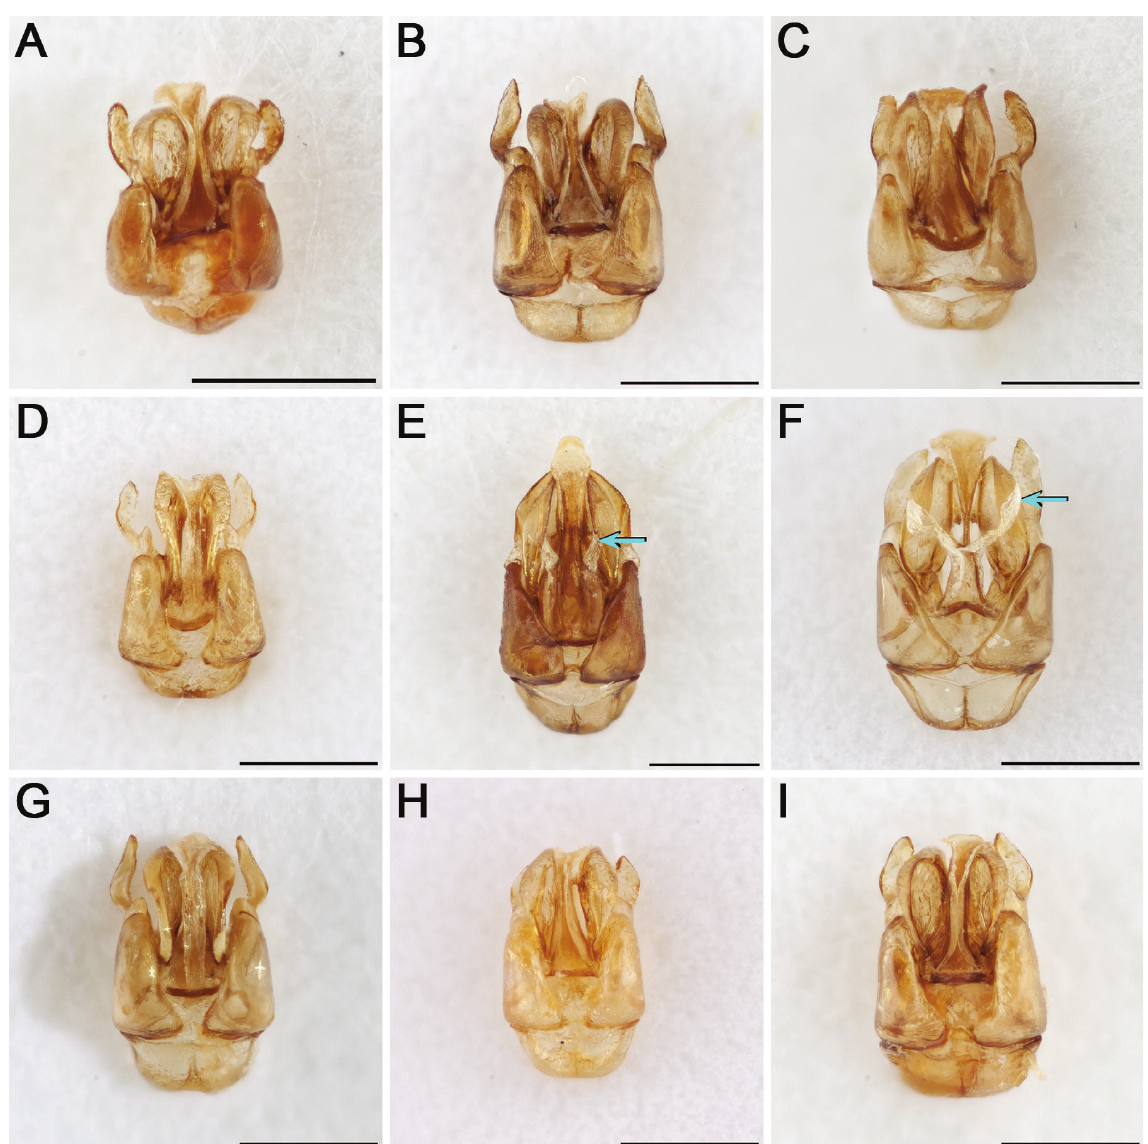
Fig. 1. Male genitalia of Epeolus spp. A . E. boliviensis Friese, 1908, in which the penis lacks lobes. B . E. claripennis Friese, 1908, in which the penis lacks lobes. C . E. fulvopilosus Cameron, 1902, in which the penis lacks lobes. D . E. fumipennis Say, 1837, in which the penis lacks lobes. E . E. hanusiae sp. nov., paratype (CNC 754086), showing the penis with a short, fleshy lateral lobe (blue arrow) on each side. F . E. luteipennis Friese, 1916, showing the penis with a long, fleshy lateral lobe (blue arrow) on each side. G . E. niger (Michener, 1954), in which the penis lacks lobes. H . E. obscuripes Cockerell, 1917 stat. nov., in which the penis lacks lobes. I . E. pulchellus Cresson, 1865, in which the penis lacks lobes. Scale bars = 0.5